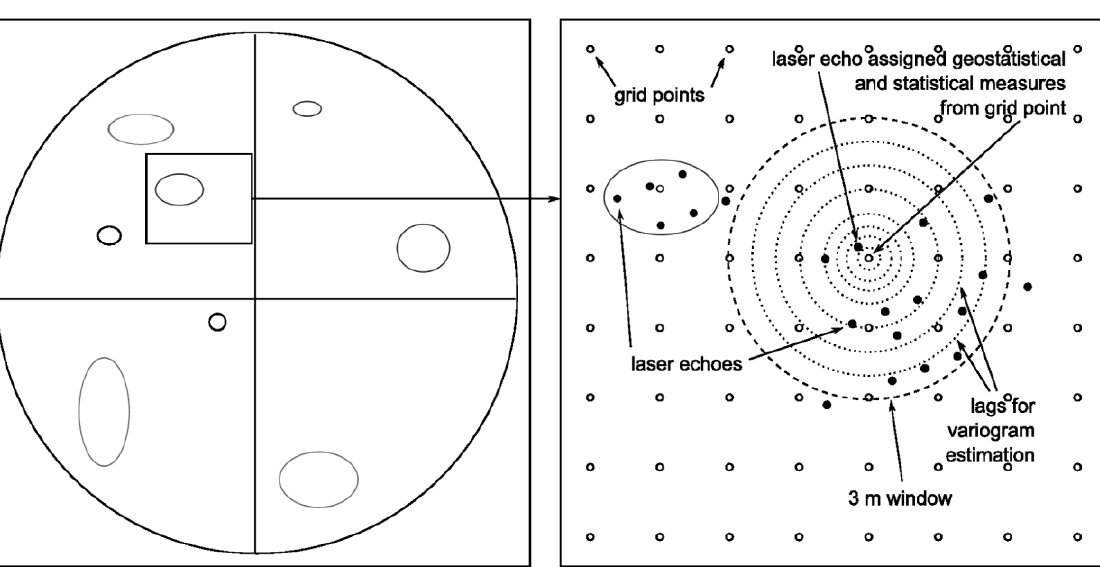
Figure 2. Illustration of a PCQ sample plot ( left , further described in the text, Section 2.2.) and a detailed demonstration of the computation of the geostatistical and statistical measures ( right ). Tree locations and the respective crown areas are represented in the three tree height classes: <1 m (black ellipses), 1–2 m (dark grey ellipses), and >2 m (light grey ellipses). Using a circular 3 m radius moving window (black dashed circle), laser echoes (black points) were selected for the computation of the geostatistical and statistical measures for each grid point (white points). The geostatistical measure was estimated using different lags (light grey dashed